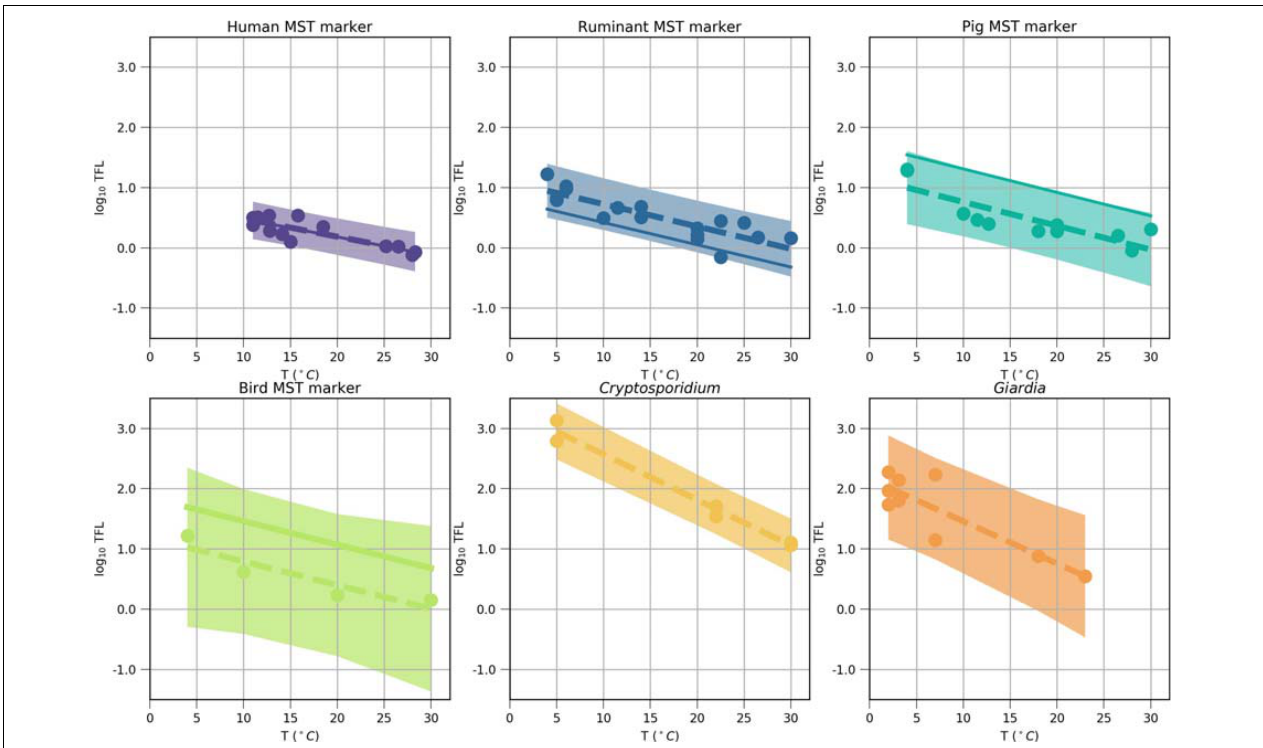
FIGURE 4 | Inactivation of the MST markers, Cryptosporidium , and Giardia after model optimization (solid lines) and as reported in experimental studies (dots, Supplementary Table 4 ), plotted as time to first log 10 reduction (TFL, days) values log 10 -transformed (log 10 (TFL) in function of the temperature. Ordinary-least-square regressions (dashed lines) were fitted to the literature values, shown with their 95% prediction intervals (shaded). The intercept and the slope of the solid lines were the result of the model optimization. These values were used as model input parameters a 0 and a 1 in Equation 2 ( Table 1